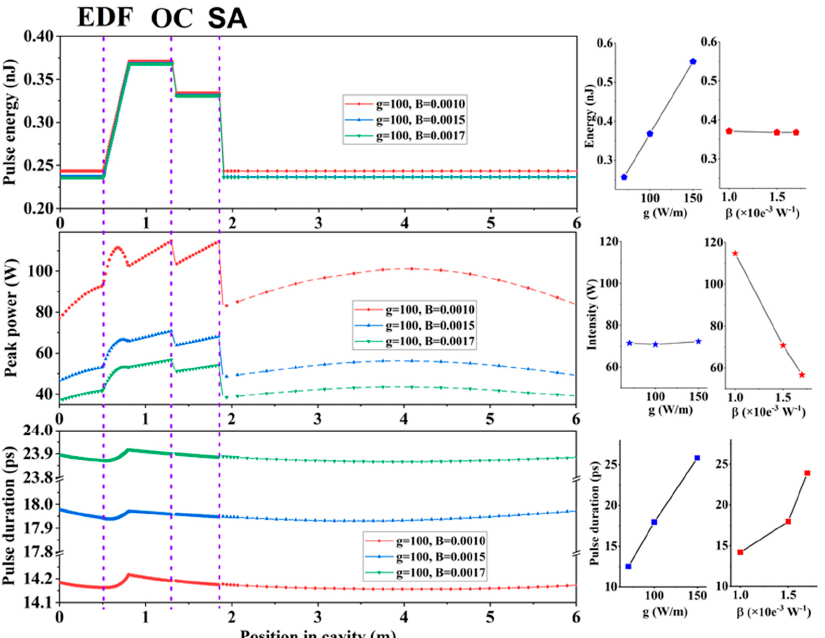
Figure 12. Intracavity pulse energy, peak power, and pulse duration as a function of position in cavity. The line charts on the right show the influence of changing relative gain coefficient and reverse absorption coefficient on pulse energy, peak power, and pulse duration.